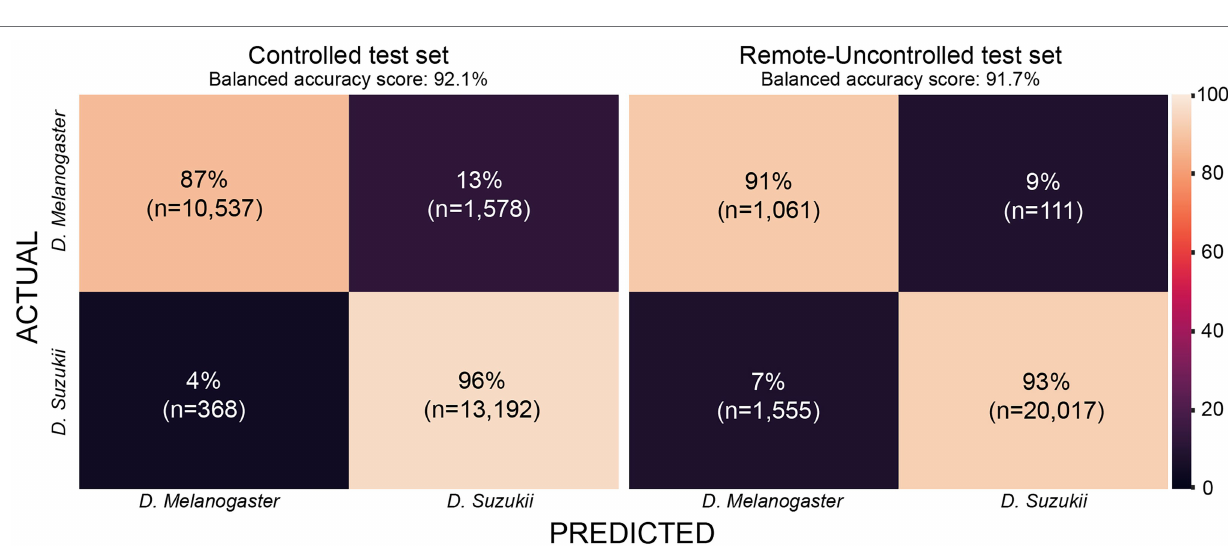
FIGURE 10 | Confusion matrix for InceptionFly trained with wingbeat time signals for our two